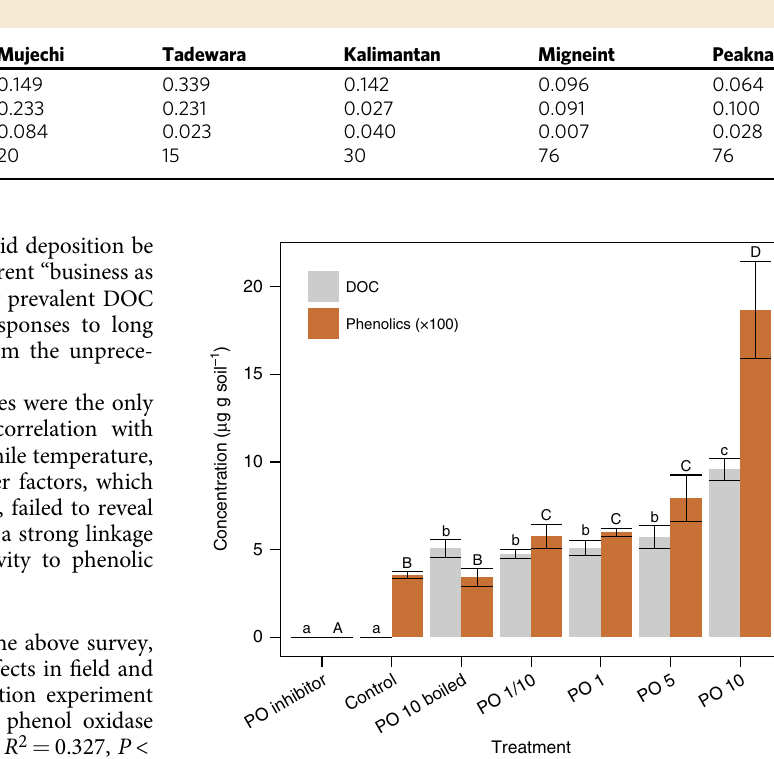
Table 2 Results of linear regressions between phenol oxidase activity in peat matrix and the concentrations of phenolics in water in each wetland